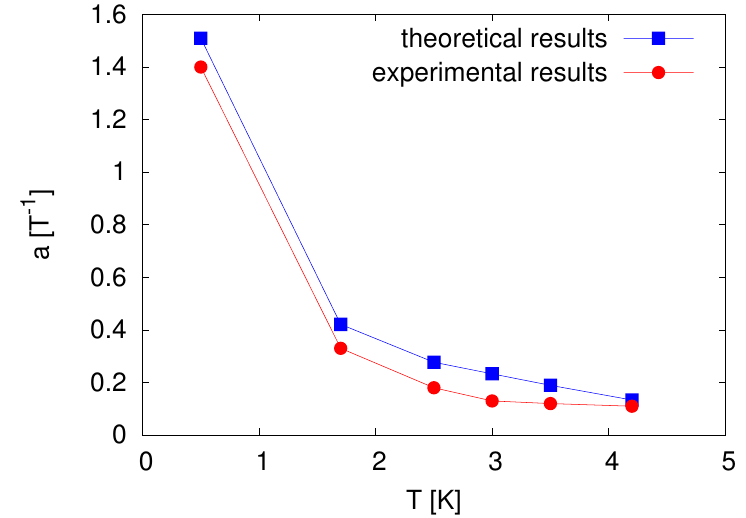
Figure 5. Theoretical results (filled square) and experimental results (filled circle) of coefficient a as a function of T in relation 1/ B 0 ∼ = a cos θ + b . Coefficient a increases as T decreases. Coefficient a especially rapidly increases at low temperatures. Theoretical and experimental results